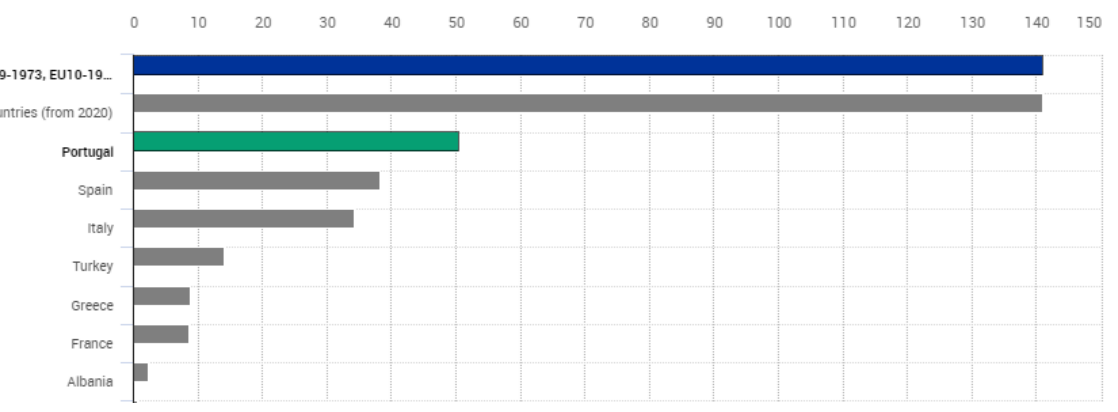
Figure 1. Crop production in EU standard humidity. Chestnut annual area (cultivation/harvested/production) (1000 ha). Source: Eurostat. Adapted from Statistics|Eurostat (europa.eu) [14].